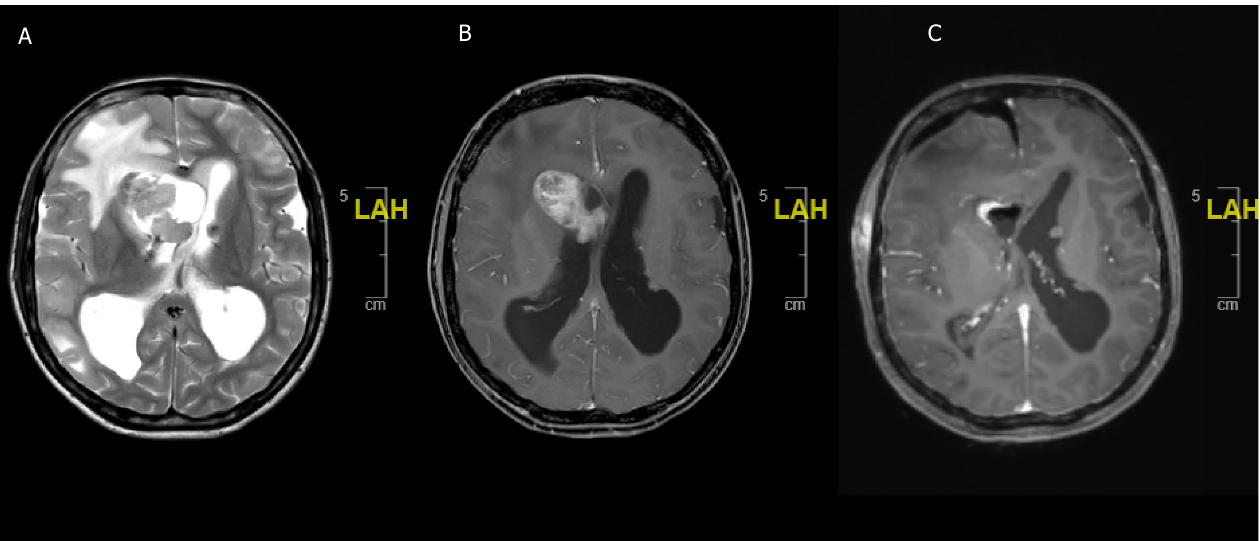
Figure 2. A 16-year-old girl previously diagnosed with TSC and presenting with acute headaches and vomiting. ( A ) Acute obstructive hydrocephalus and edema due to T2 hypointense lesion in the right frontal horn. ( B ) Contrast enhancing lesion in the right frontal horn suggestive of SEGA in the context of TSC. ( C ) Postoperative scan with reduction of ventricular size and showing complete resection of the